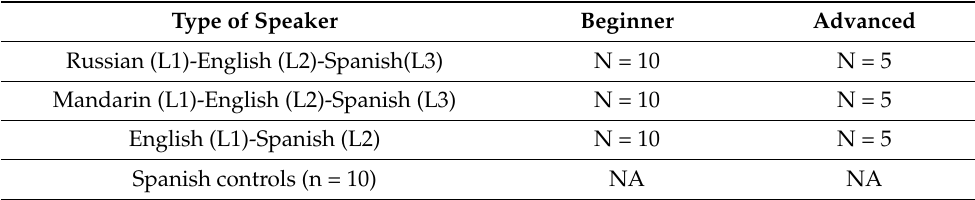
Table 1. Participant profile.